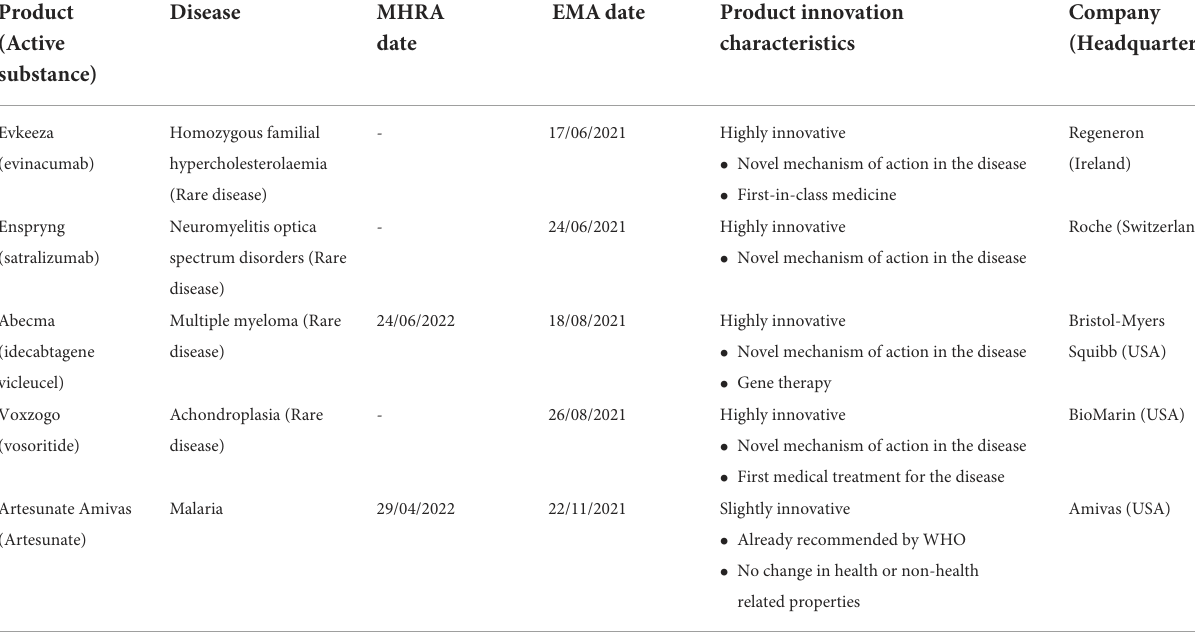
TABLE 1 Novel products authorized by EMA in 2021 with lack or delay in authorization by